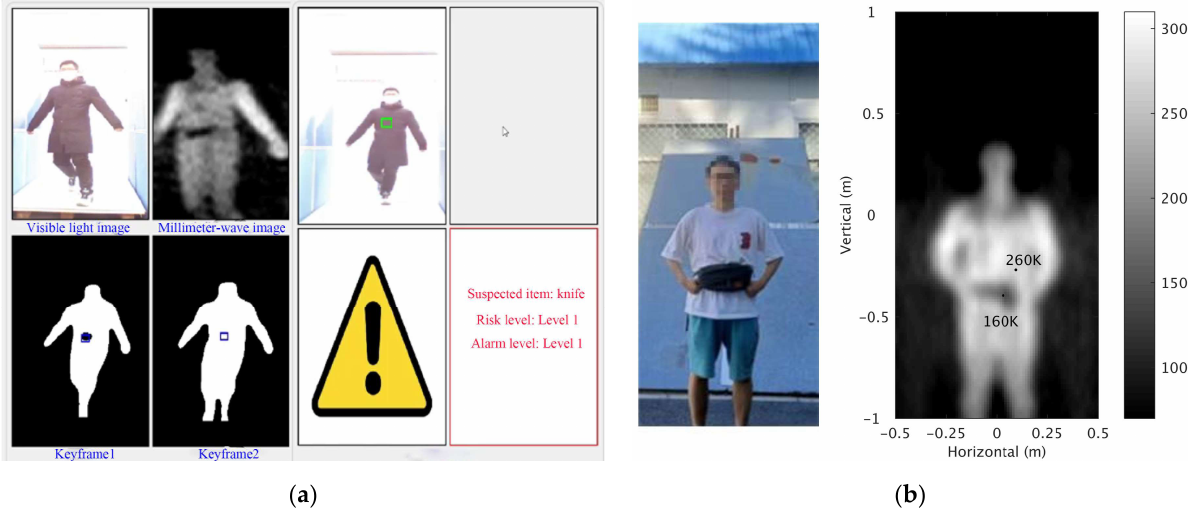
Figure 28. ( a ) Screenshots of the system software . ( b ) Imaging results of the inspected person with metal gun model.